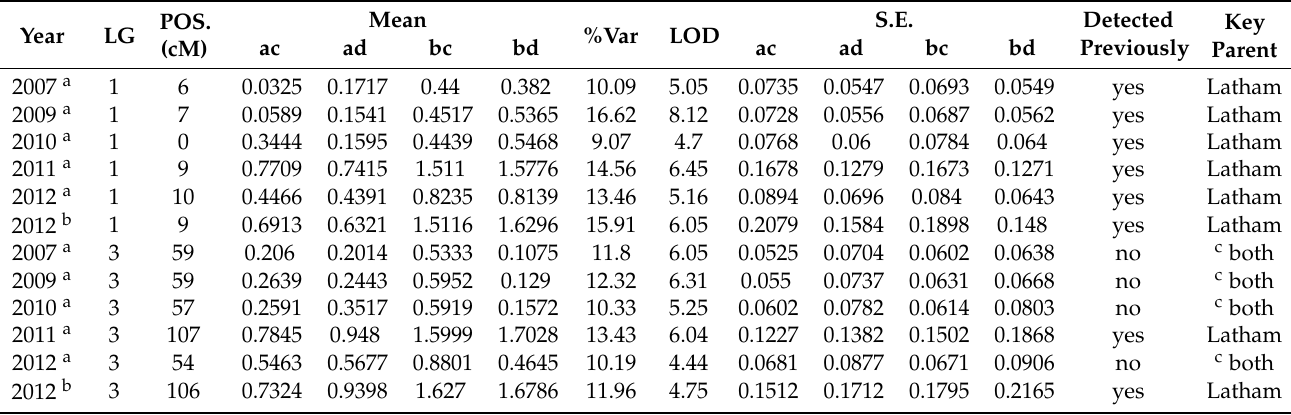
a incidence scores— b severity scores— c Latham and Glen